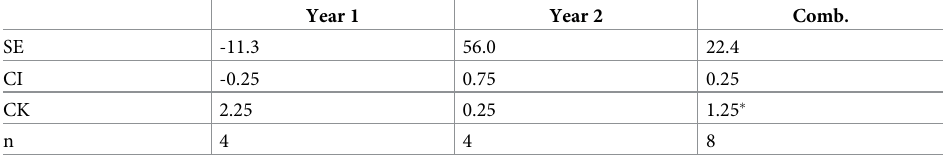
Table 7. Average gains in self-efficacy, career interest, and career knowledge in DIVAS Seminar II.